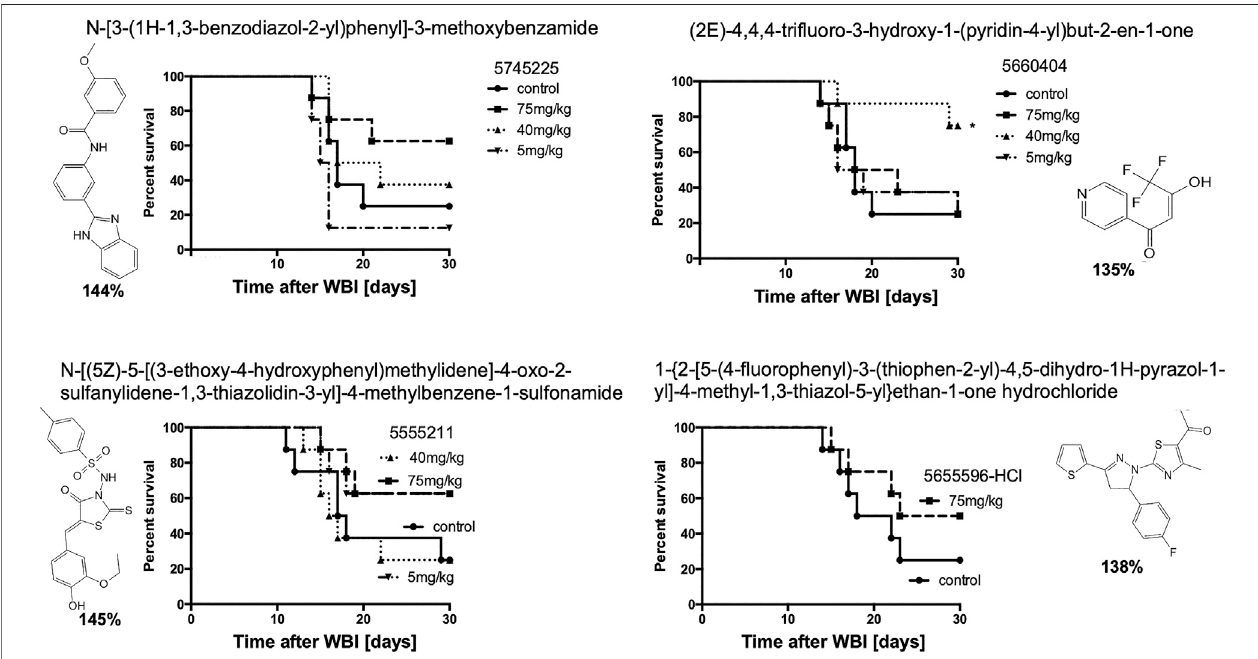
FIGURE 7 | Other, lesser HTS “ hits ” tested in C3H mice with 5X daily drug doses, as stated, starting 24 h after WBI at LD70/30 doses. * p < 0.05.